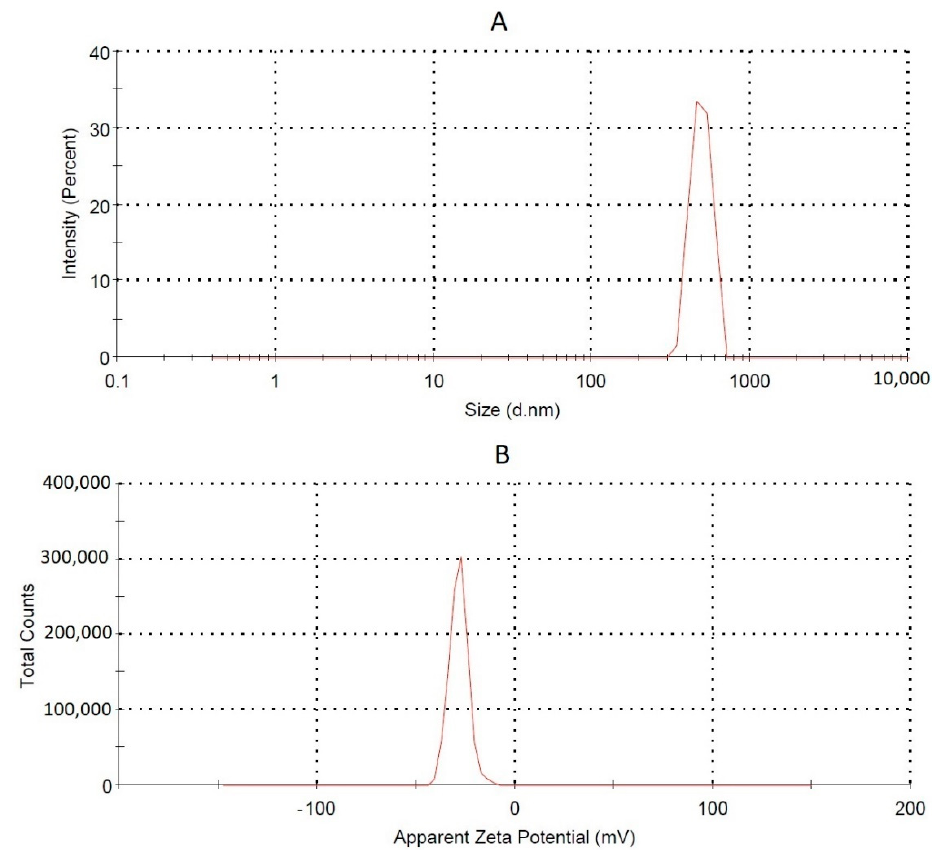
Figure 5. Globule size, A , and zeta potential, B , of the selected SNEDDS formulation